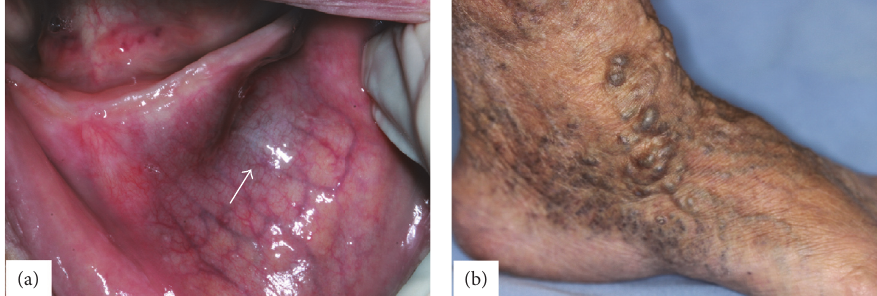
Figure 1: Clinical appearance of the submucosal nodule on the lower labial mucosa (arrow) (a). The same patient presented numerous varices of irregular shape and variable size in the foot (b).